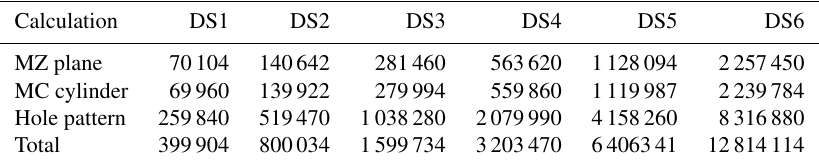
Table A1. Amount of measurement points per test data set.